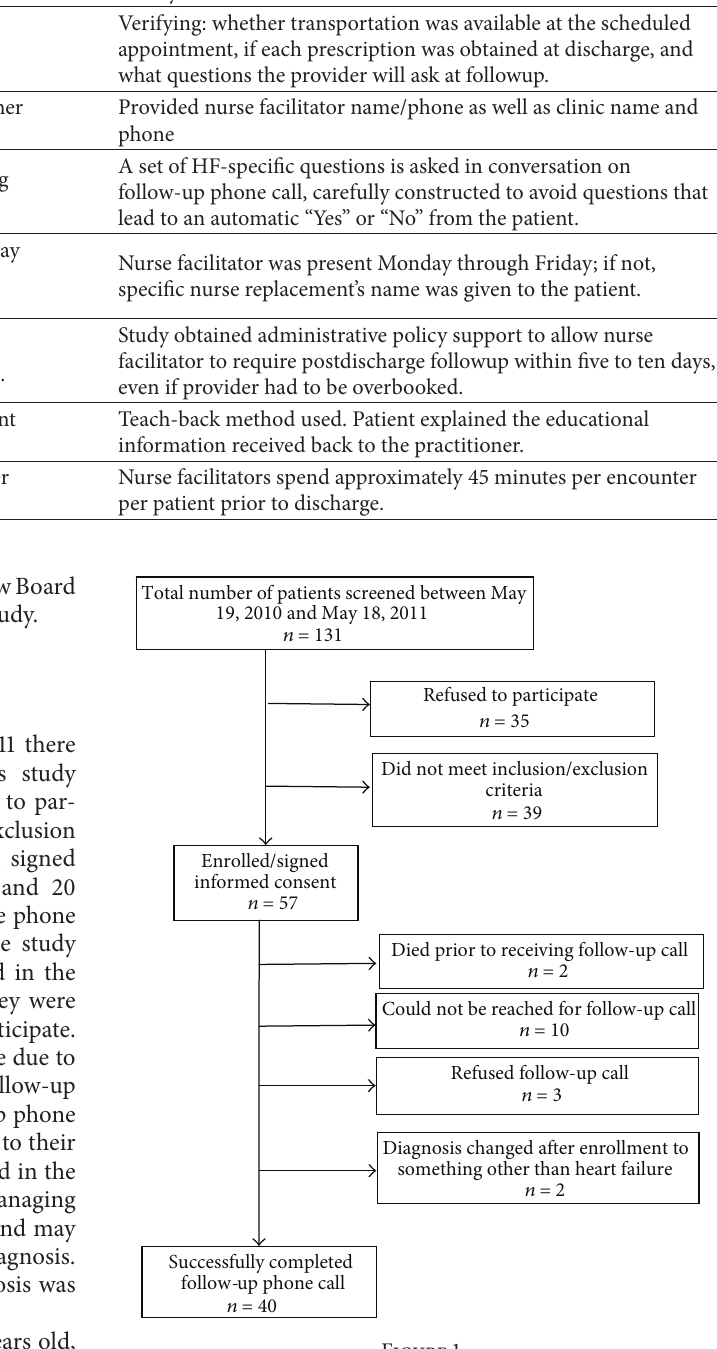
between study groups and the presence of comorbid condi- tions such as renal diseases, chronic obstructive pulmonary disease, diabetes mellitus, atrial fibrillation, hypertension, stroke, coronary artery disease, and